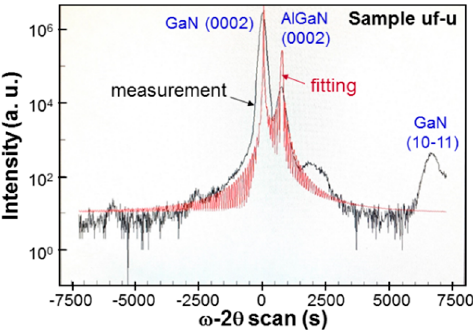
Figure 2. The results of ω -2 θ scan in X-ray diffraction (XRD) measurement for sample uf-u. The black (red) curve shows the measurement data (fitting curve).